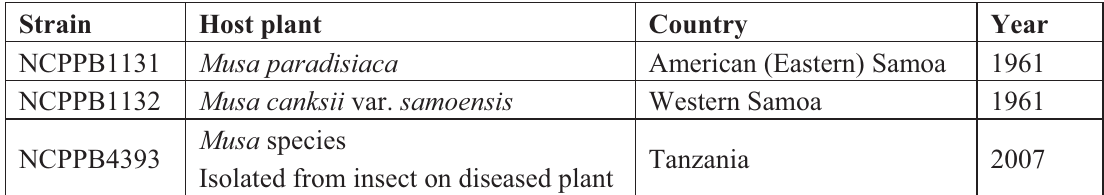
Table 1. Bacterial strains sequenced in this